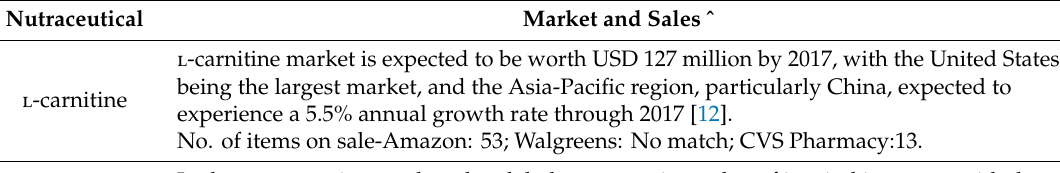
Table 3. Economic issues for the reviewed